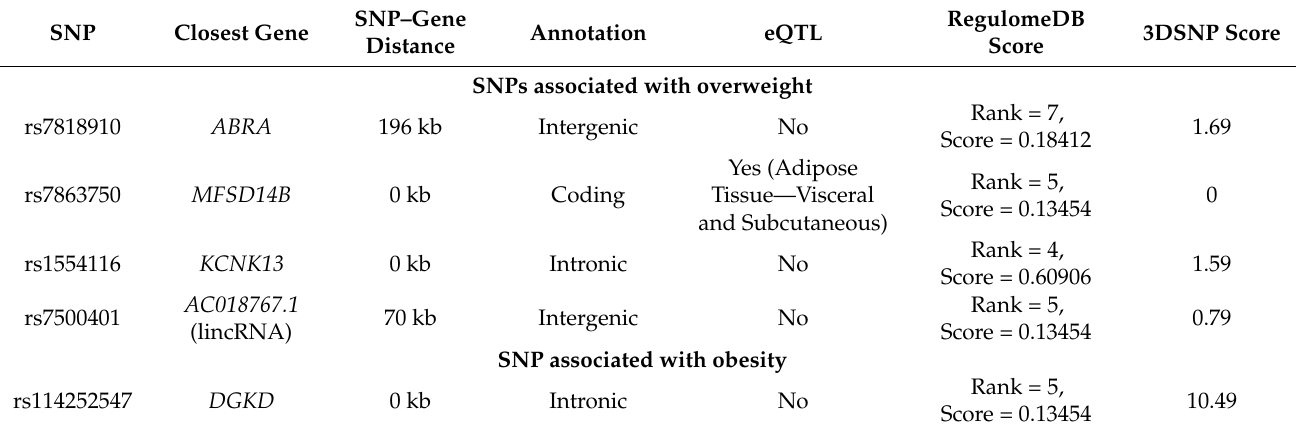
Table 4. Annotation and functional characterization of the SNPs found to be associated with over- weight and obesity according to GTex portal [22], RegulomeDB [26], and 3DSNP